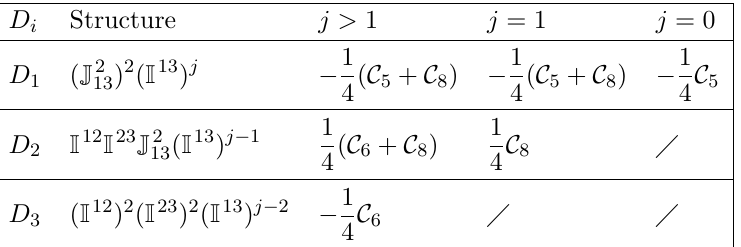
Table 11 . Expansion of the supersymmetric correlator in the component spin ( 1 j; 0). 2